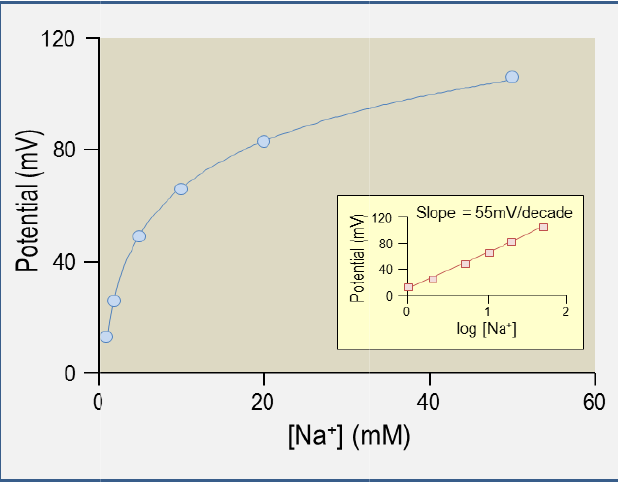
Figure red using Na aCl solution